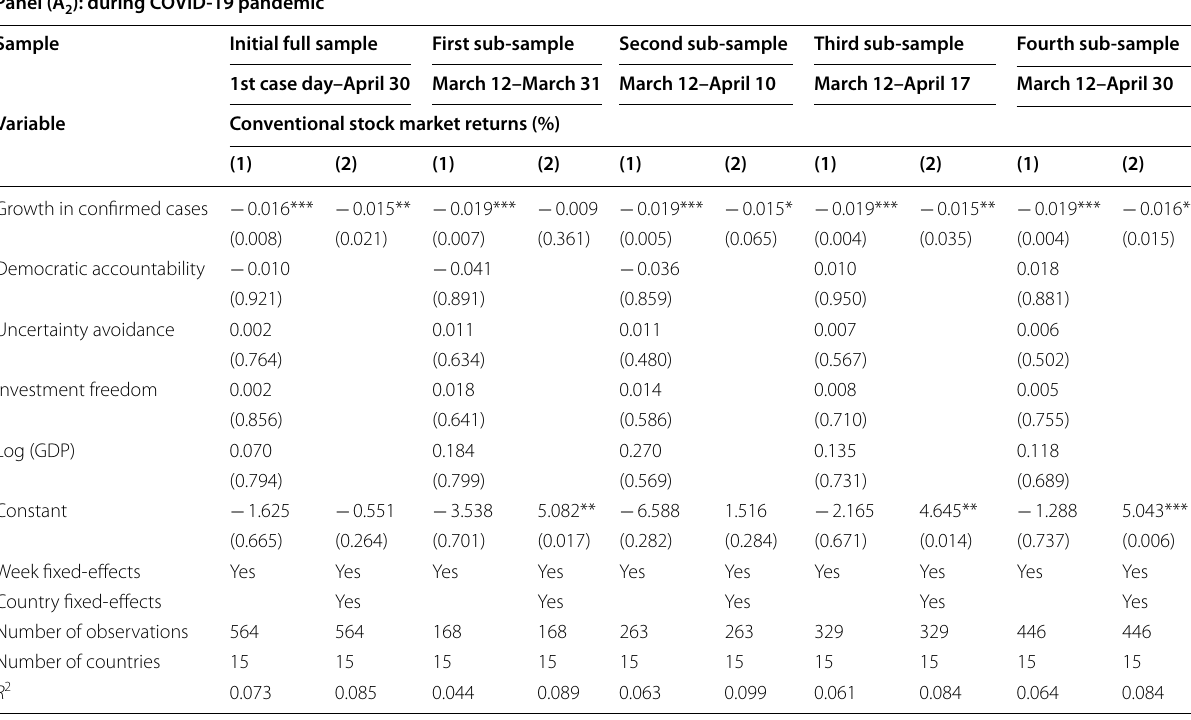
***, **, *Represent statistical significance at 1%, 5%, and 10% levels, respectively; p -values are given in parenthesis; Panel (A 2 ) represents the period during COVID- 19 (the day when 1st COVID-19 case was confirmed in a country – April 30, 2020); VIF values for each model do not indicate multicollinearity problem; 1st case day denotes 1st COVID-19 case was confirmed in a country; March 12, 2020 is the first day when all the 15 countries in the sample reported at least one positive case (see Table 1); The panel pooled OLS regression is employed with the heteroskedasticity robust standard